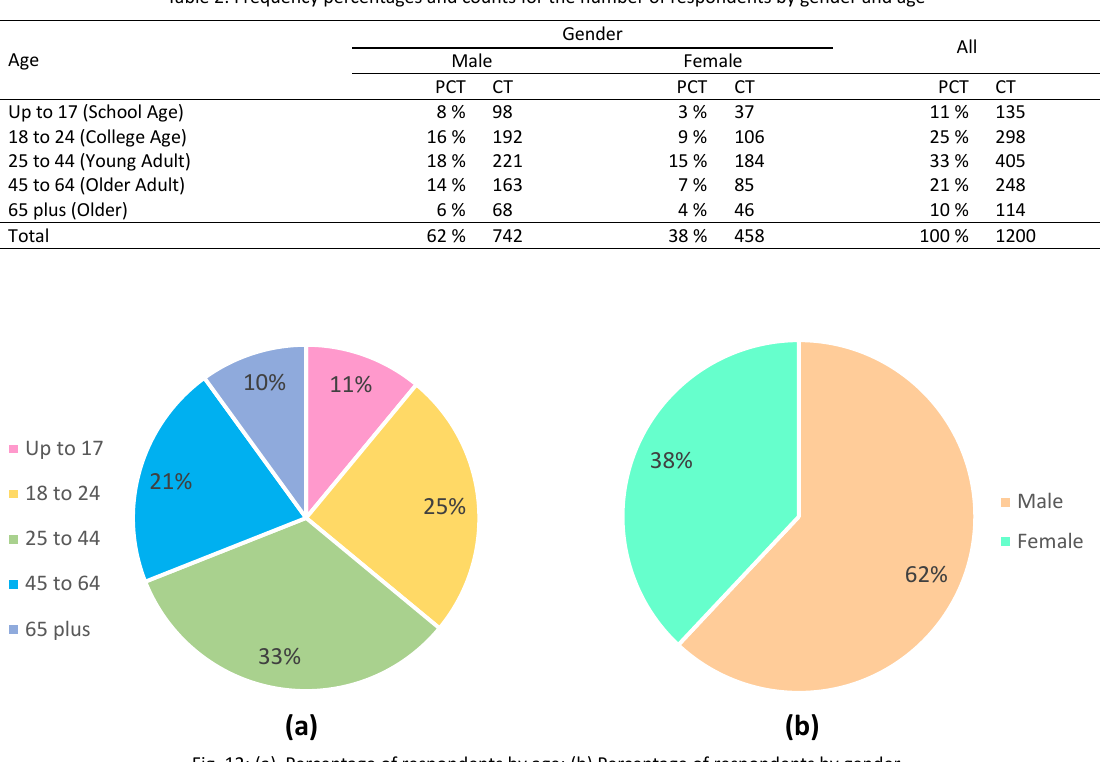
Table 2: Frequency percentages and counts for the number of respondents by gender and age